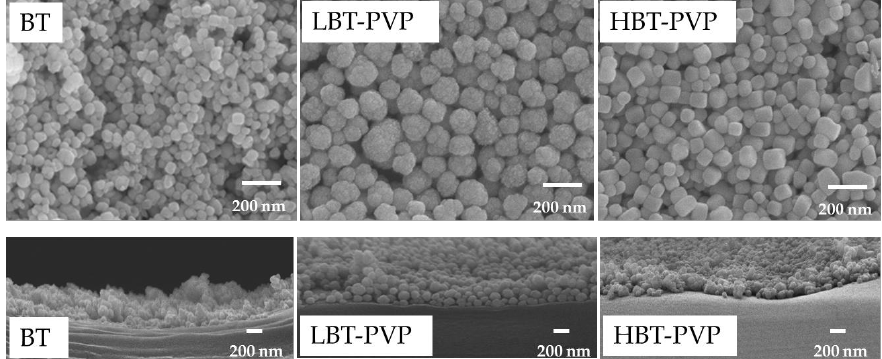
Figure 5. SEM images of the thin films surface ( top ), and cross section ( down ). These films were